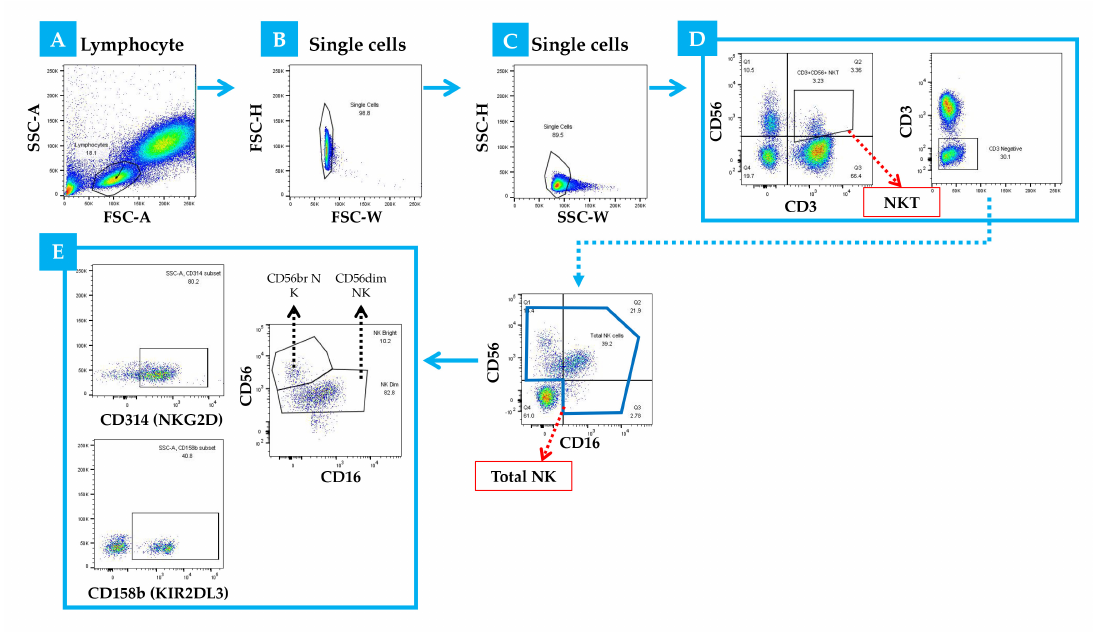
Fig. 3. Flow cytometry analysis of NK cells and receptors in the elderly. A front scattered light (FSC)-A and side scattered light (SSC)-A plot was used to identify nucleated cells. (A) A lymphocyte gate was set based on the size and granularity of the cells. (B) Single cells were gated, and doublets were excluded. (C) CD14+ macrophages were excluded. (D) NK cells were defined as CD3- CD56+. (E) Two NK cell subsets were identified: CD16+ and CD16- NK cells. NKG2D and KIR2DL3 were defined as CD314 and CD158b,